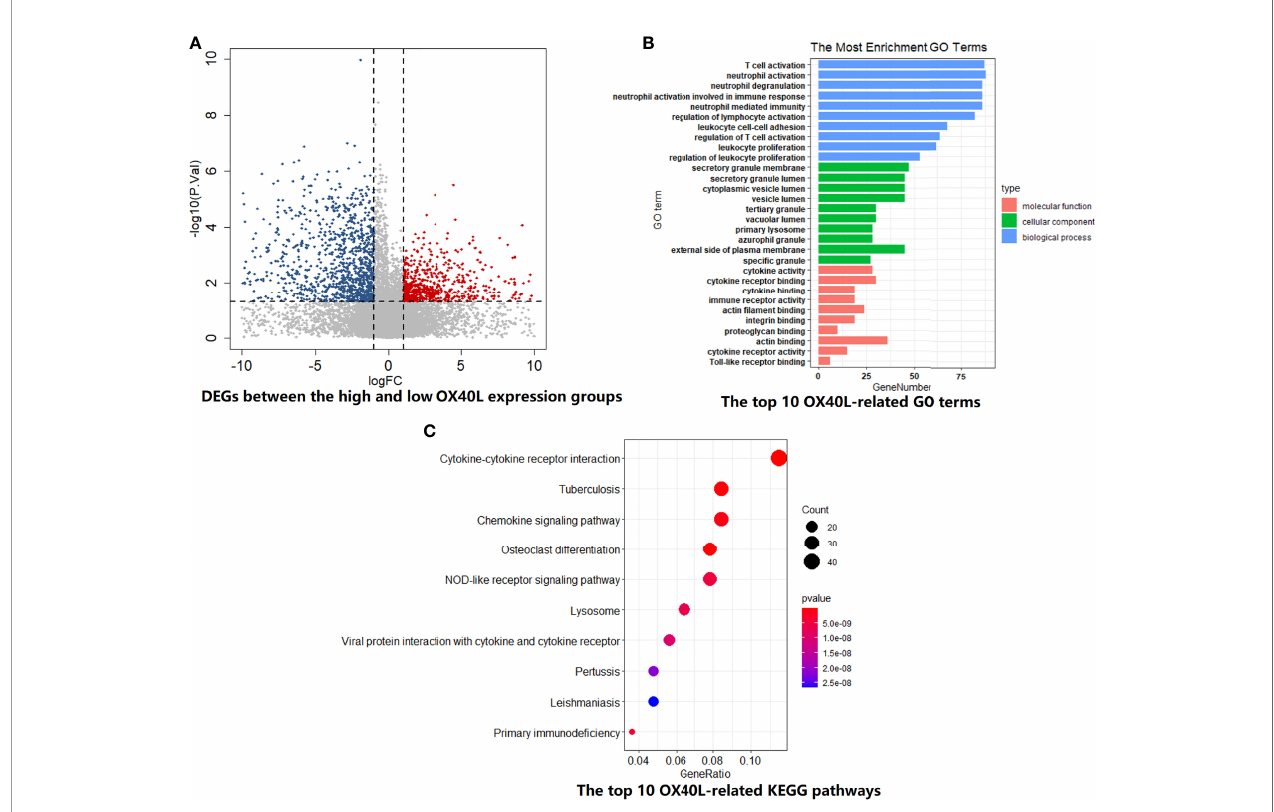
FIGURE 4 | The biological functions and pathway enrichment of OX40L-related DEGs in SCLC. (A) A total of 3048 DEGs were identi fi ed between the high and low OX40L expression group. (B) The GO enrichment results of OX40L-related DEGs in SCLC. Go terms were divided into three types, including cellular component, biological process, and molecular function. (C) The KEGG enrichment results of OX40L-related DEGs in SCLC. DEGs, differentially expressed genes; GO, Gene Ontology; KEGG, Kyoto Encyclopedia of Genes and Genomes; SCLC, small cell lung cancer; OX40L, OX40